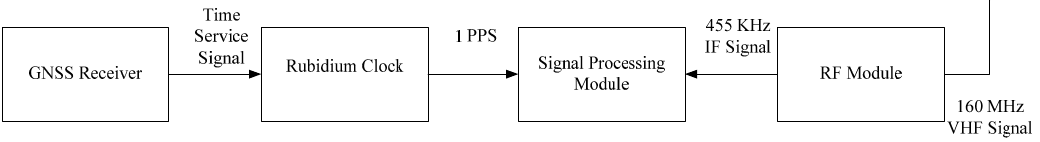
Figure 5. The structure diagram of the receiver in the ASF correction system.